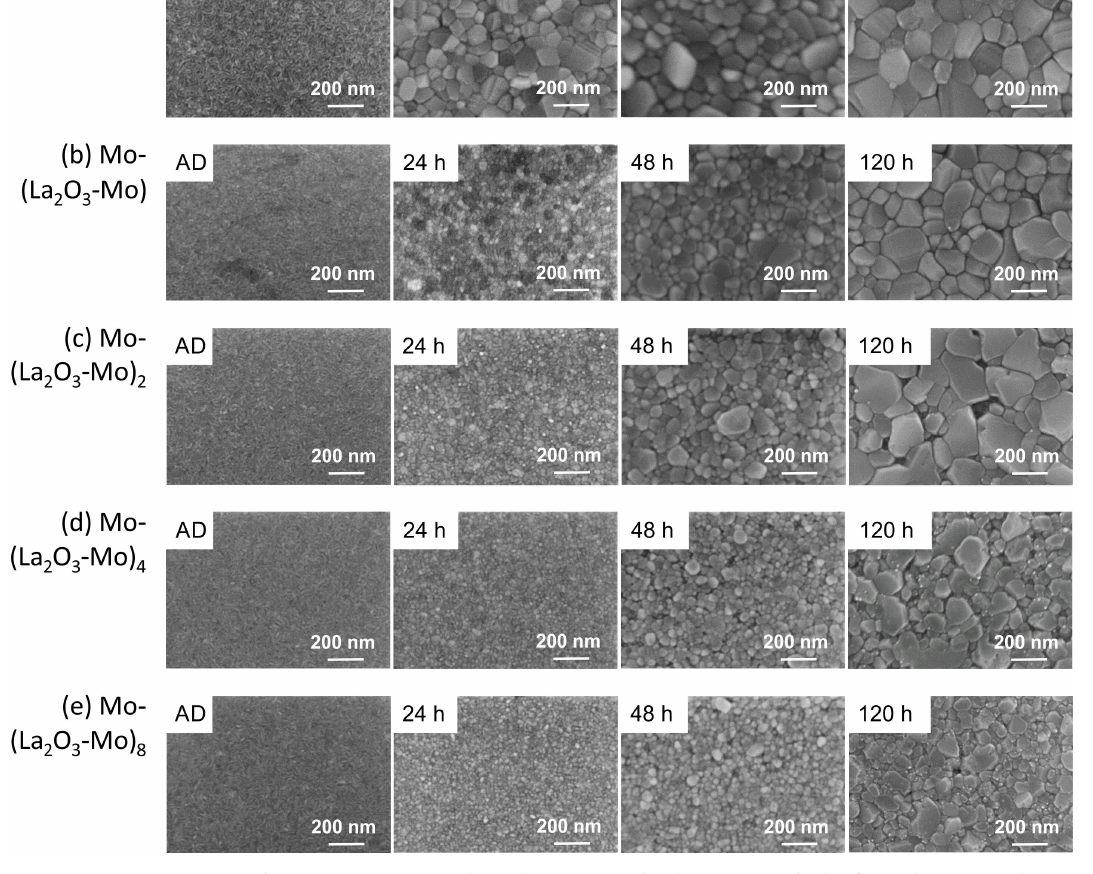
Figure 3. Scanning electron microscopy (SEM) micrographs (inLens, 20 kV) of Mo-(La 2 O 3 -Mo) n multilayer systems on SiO 2 /Si in the as-deposited state (AD) and after thermal treatment for different time durations in high vacuum at 800 ◦ C ( a ) pure Mo, ( b ) Mo-(La 2 O 3 -Mo), ( c ) Mo-(La 2 O 3 -Mo) 2 , ( d ) Mo-(La 2 O 3 -Mo) 4 and ( e ) Mo-(La 2 O 3 -Mo) 8